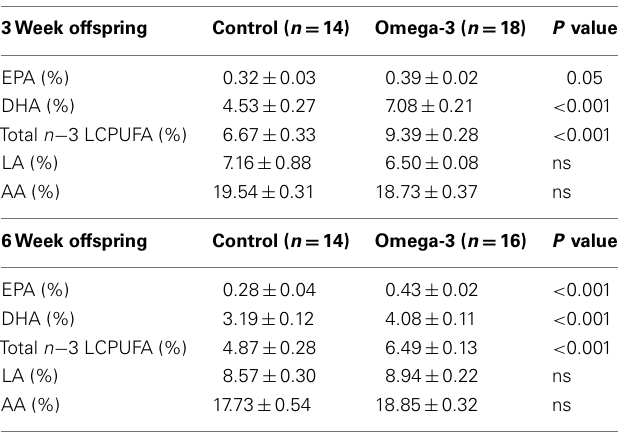
Table 3 | Erythrocyte phospholipid fatty acid composition expressed as a percentage of total fatty acids at 3 and 6weeks of age in offspring of Control and Omega-3 dams.